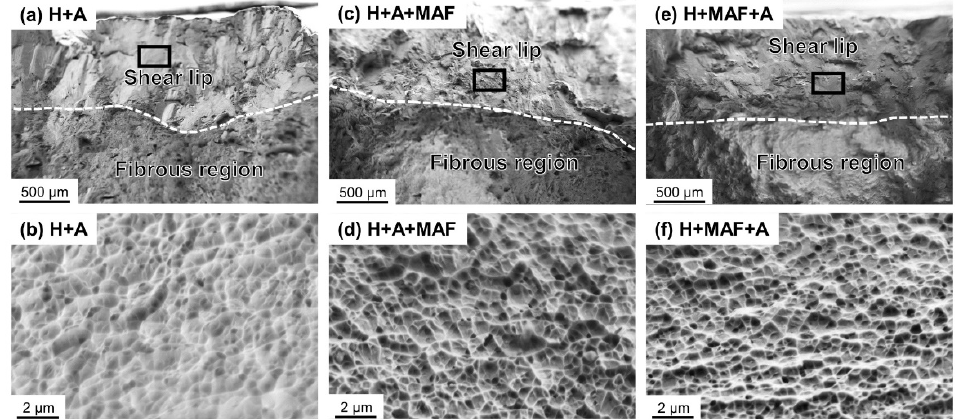
Figure 6. Fractography of ( a ) the fully heat-treated sample H + A (without the MAF process) and ( b ) magnified area of sample H + A in the shear lip region; ( c ) sample H + A + MAF (with the MAF process after full heat treatment) and ( d ) magnified area of sample H + A + MAF in the shear lip region; and ( e ) sample H + MAF + A (with the MAF process between the homogenization and aging processes) and ( f ) magnified area of sample H + MAF + A in the shear lip